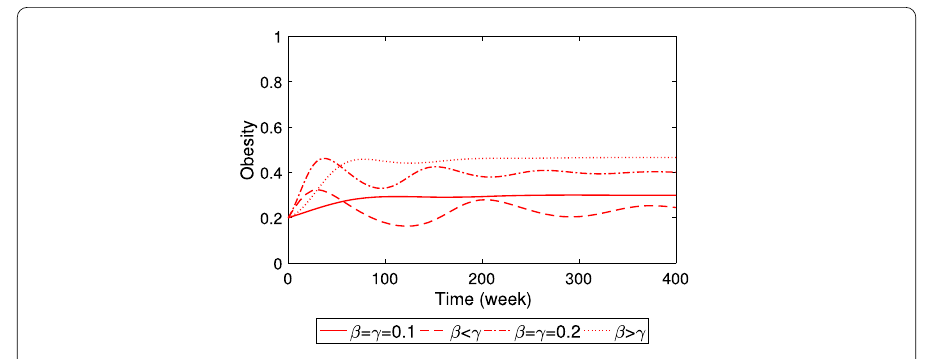
Figure 3 Obese compartment vs. time with varying β and